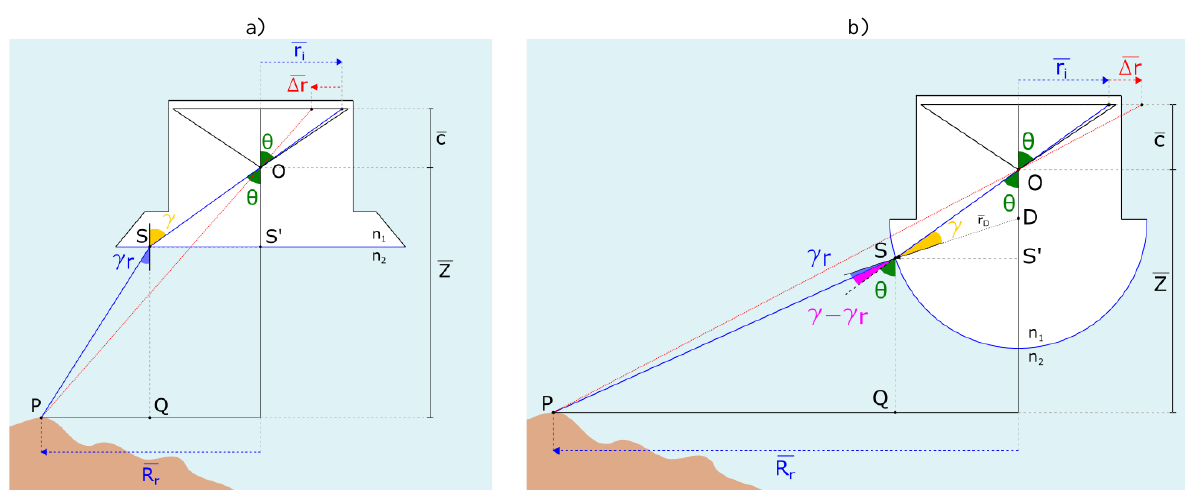
Figure 1. Schematic representation of refractive effects in the image formation for a flat port (a) and a misaligned dome port